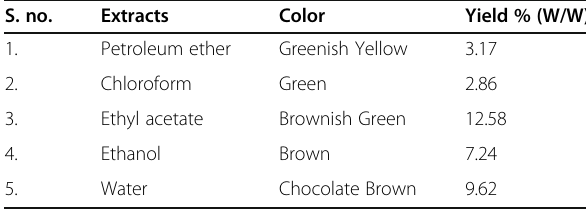
Table 1 Percentage yield and color of various solvent extracts from Clerodendrum thomsoniae